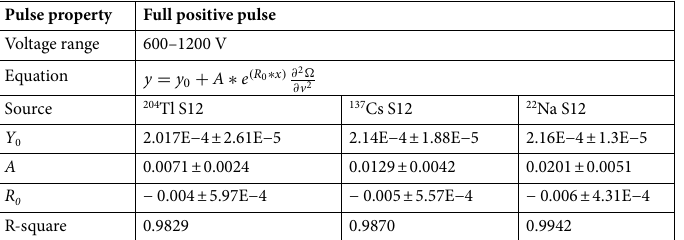
Table 3. Statistical parameters for best fit lines in Fig. 3. OriginPro software (version 2020b) was used to derive best fit